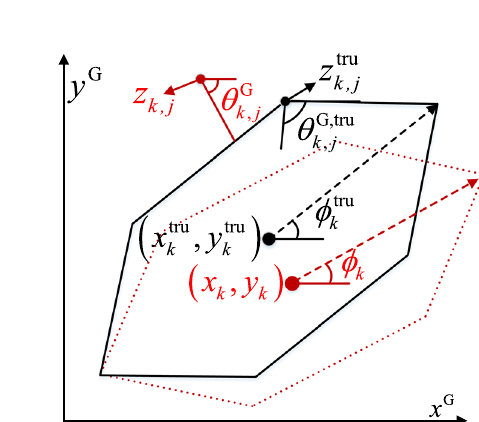
Fig. 2 Actual meaning of the input uncertainty in GP-ETT: red dashed line and variables represent the contour estimates state and the corresponding variables; black solid line and variables denote the truth contour state and the corresponding